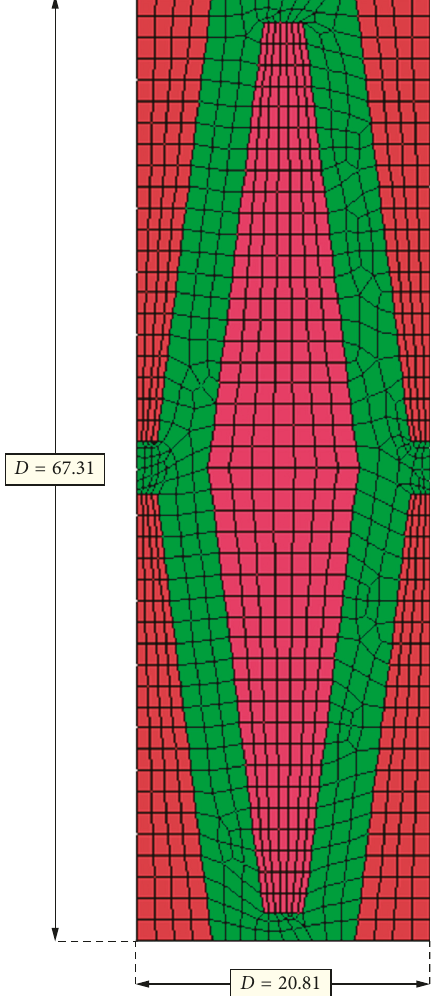
Figure 3: Representative volume element at the meso-level (di- mensions in